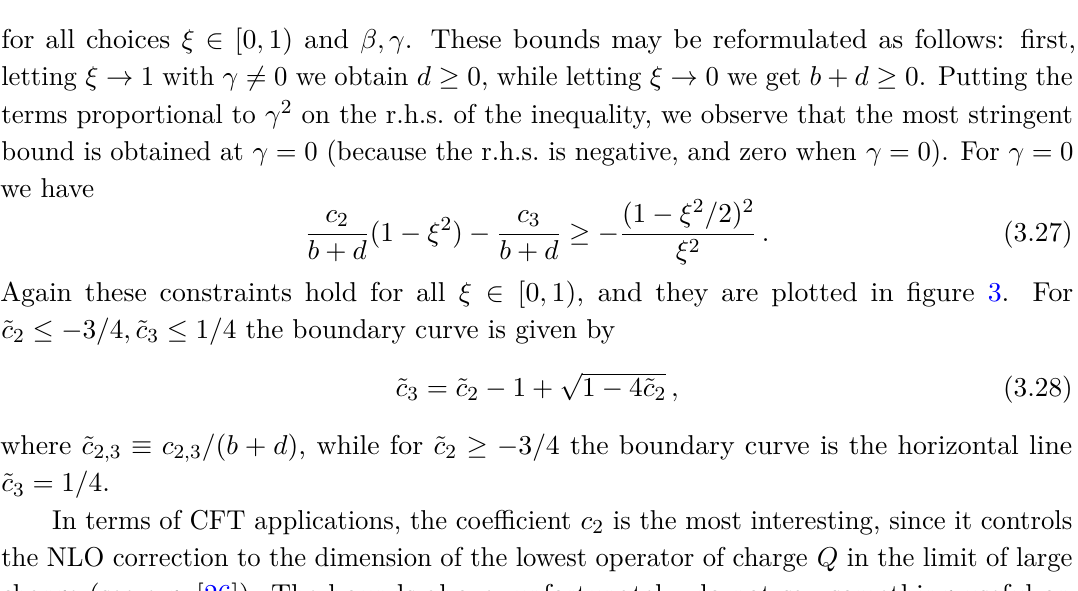
Figure 3 . The constraints (3.27) (the blue region is allowed). There are also the constraints d ≥ 0 and b + d ≥ 0 . c 1 > 0 is required to have a healthy kinetic term for